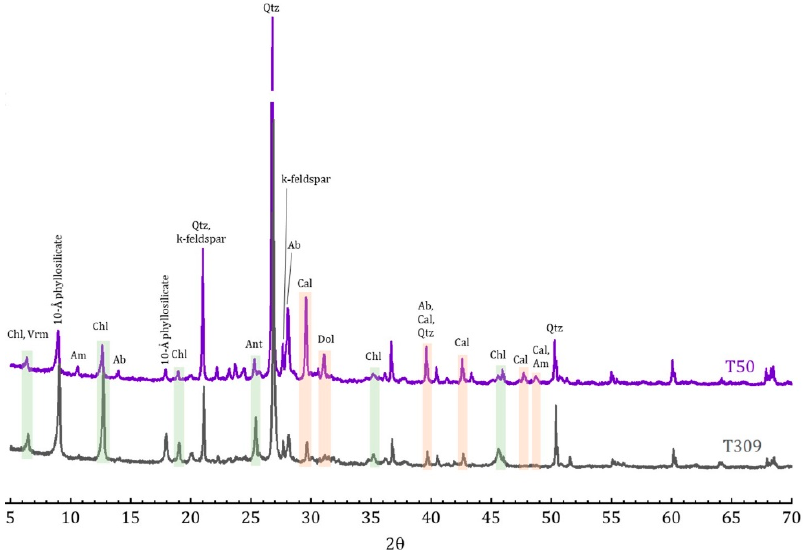
Figure 6. X-ray diffraction (XRD) patterns for the dust sampled from the deepest layers of the GS (T50) and the GP (T309) cores discussed in this study. The T50 diffractogram is shifted up to allow the identification of key features and to facilitate the visual comparison with T309. The orange and green shadings highlight minerals found in higher abundance, respectively, in T50 and in T309 (conventional mineral abbreviations from USGS.gov).